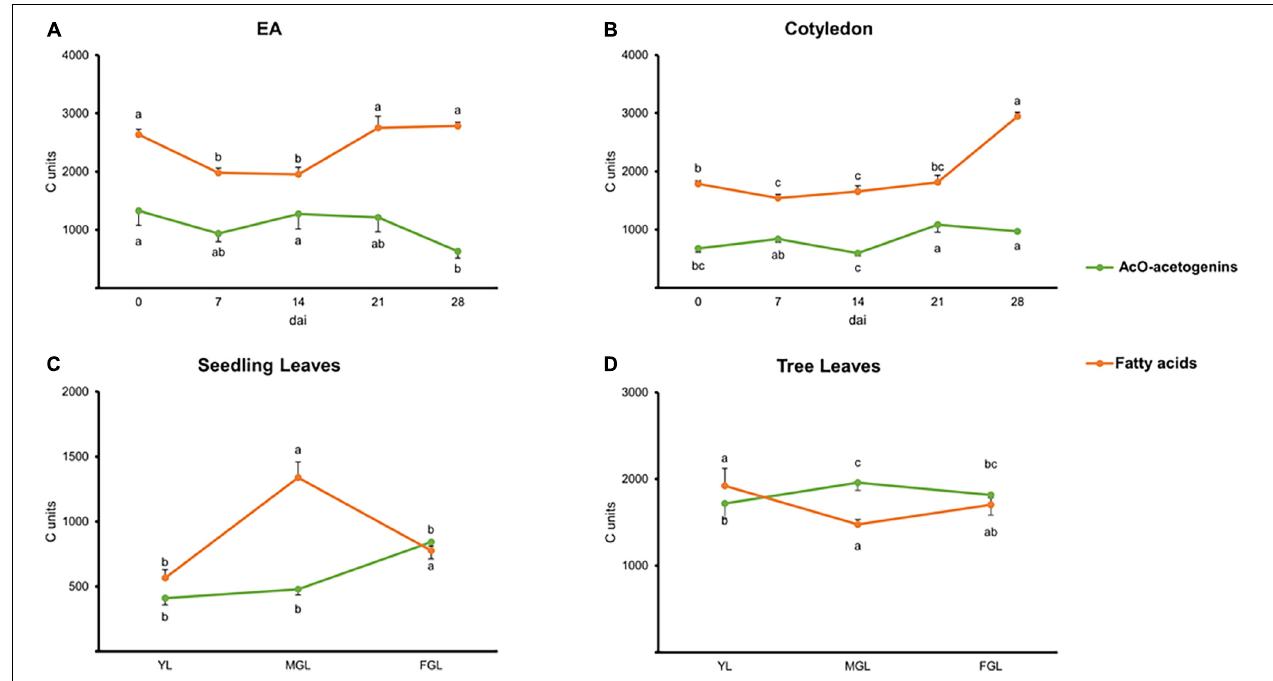
FIGURE 3 | Carbon units are allocated into acetogenins and FAs. (A) EA. (B) Cotyledon. (C) Seedling leaves. (D) Tree leaves. Points indicate mean values. Error bars indicate SE. Error bars and statistical groups are shown above the line for FA and below the line for acetogenins. Different letters indicate significant statistical differences between treatments (ANOVA, Fisher LSD, P < 0.05). n = 4 for EA and Cotyledon; n = 3 for leaves. EA embryonic